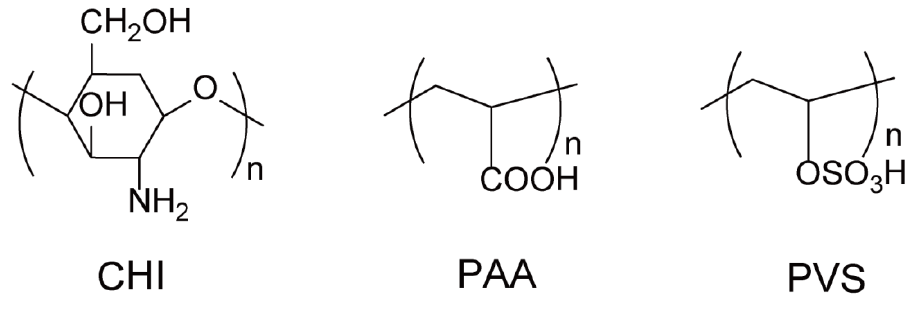
Figure 1. Chemical structures of chitosan (CHI); poly(acrylic acid) (PAA); and poly(vinyl sulfate)